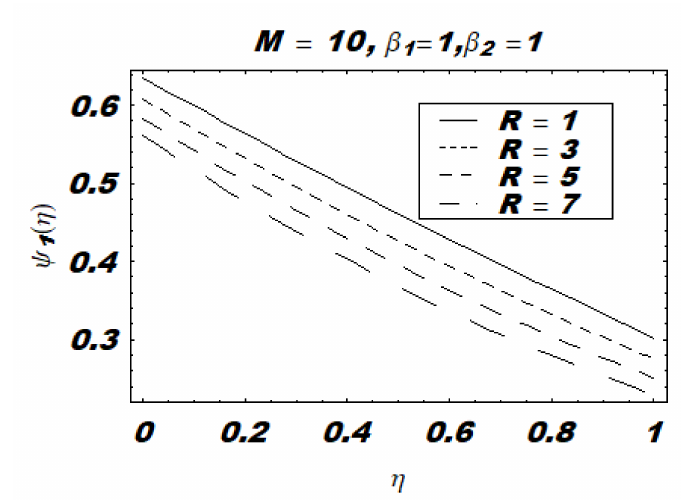
Figure 18. Similarity function ψ /